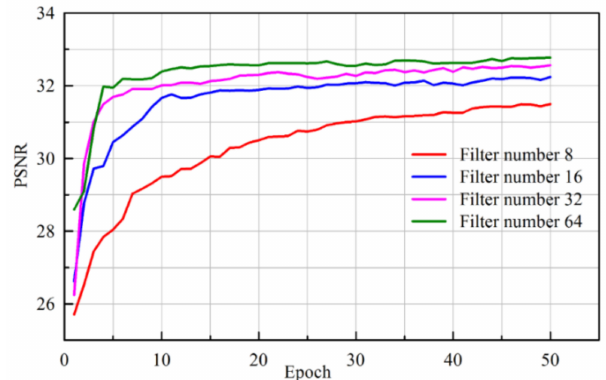
Figure 4. PSNR values on the validation set during training with different filter numbers.